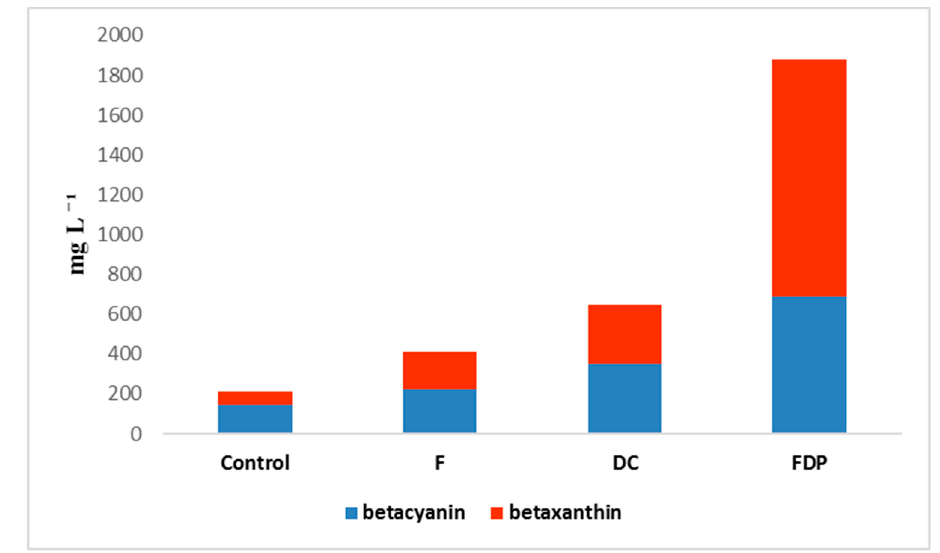
Figure 4. The betacyanin (BC) and betaxanthin (BX) content and their ratio in the experimental variants.